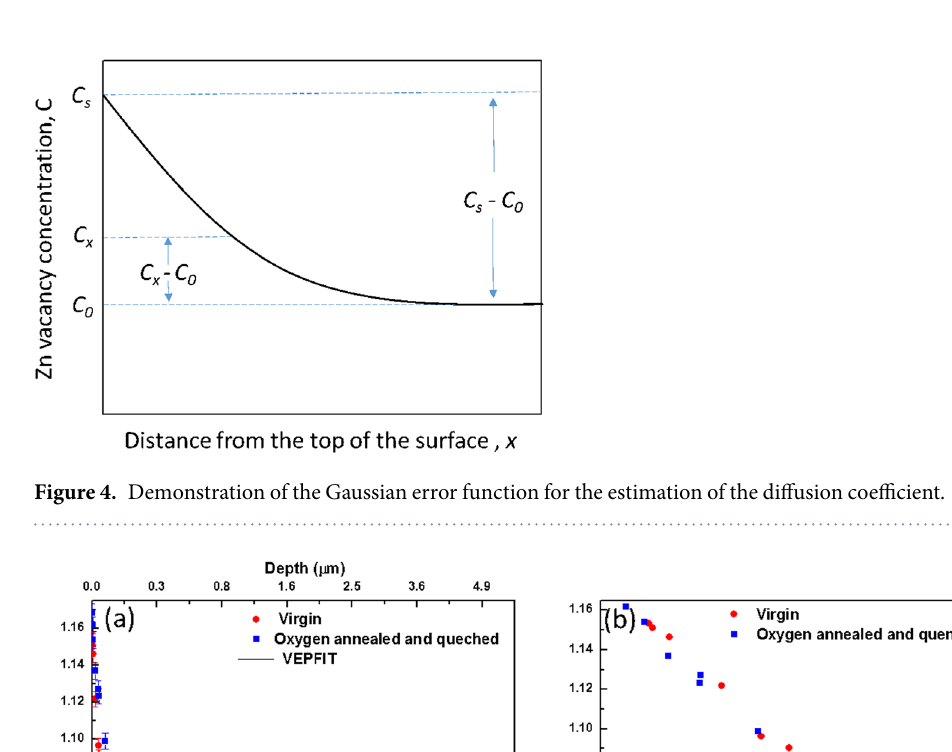
Table 1. Formation energy, where subscripts a and b denote the top and the mid regions,